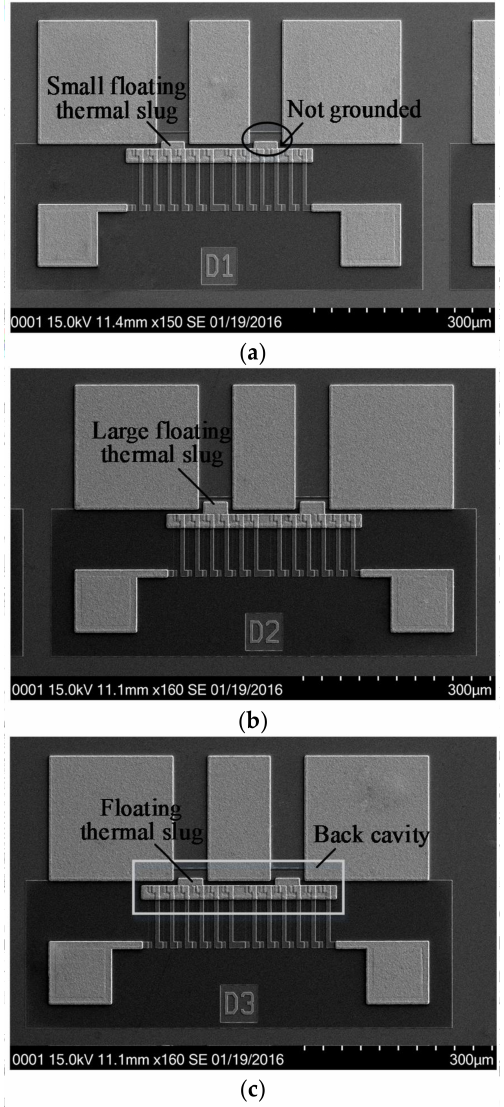
Figure 6. SEM views of three wideband and low-loss MEMS thermoelectric microwave power sensors in GaAs MMIC. ( a ) Sensor D1 with the overlapping length of 2 µ m (small floating thermal slug); ( b ) Sensor D2 with the overlapping length of 10 µ m (large floating thermal slug); and, ( c ) Sensor D3 with the floating thermal slug and the back cavity.